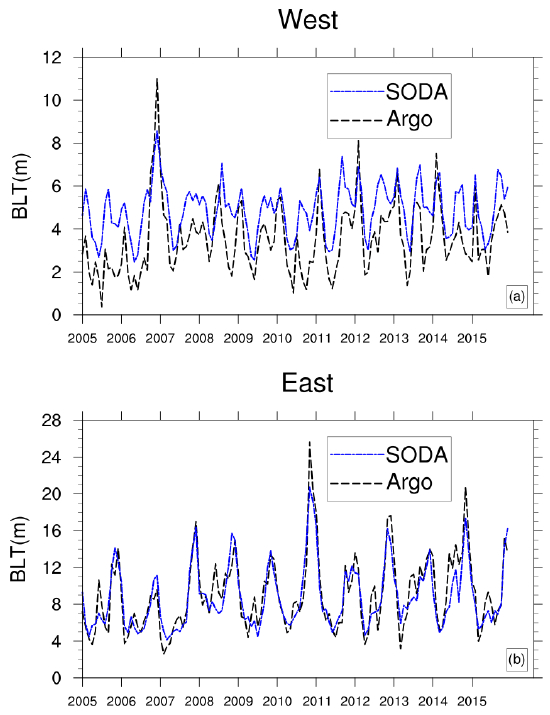
Figure 3. Interannual time series of the region-averaged BLT for SODA and Argo: (a) the western TIO (12 ◦ S–5 ◦ N, 55–75 ◦ E) and (b) the eastern TIO (12 ◦ S–5 ◦ N, 85–100 ◦